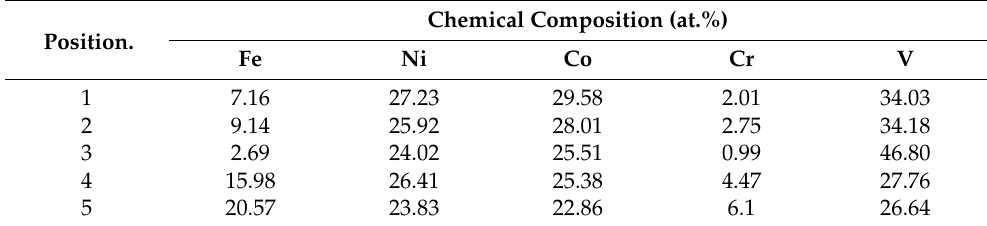
Table 4. EDS results of representative positions are indicated in Figure 9f.